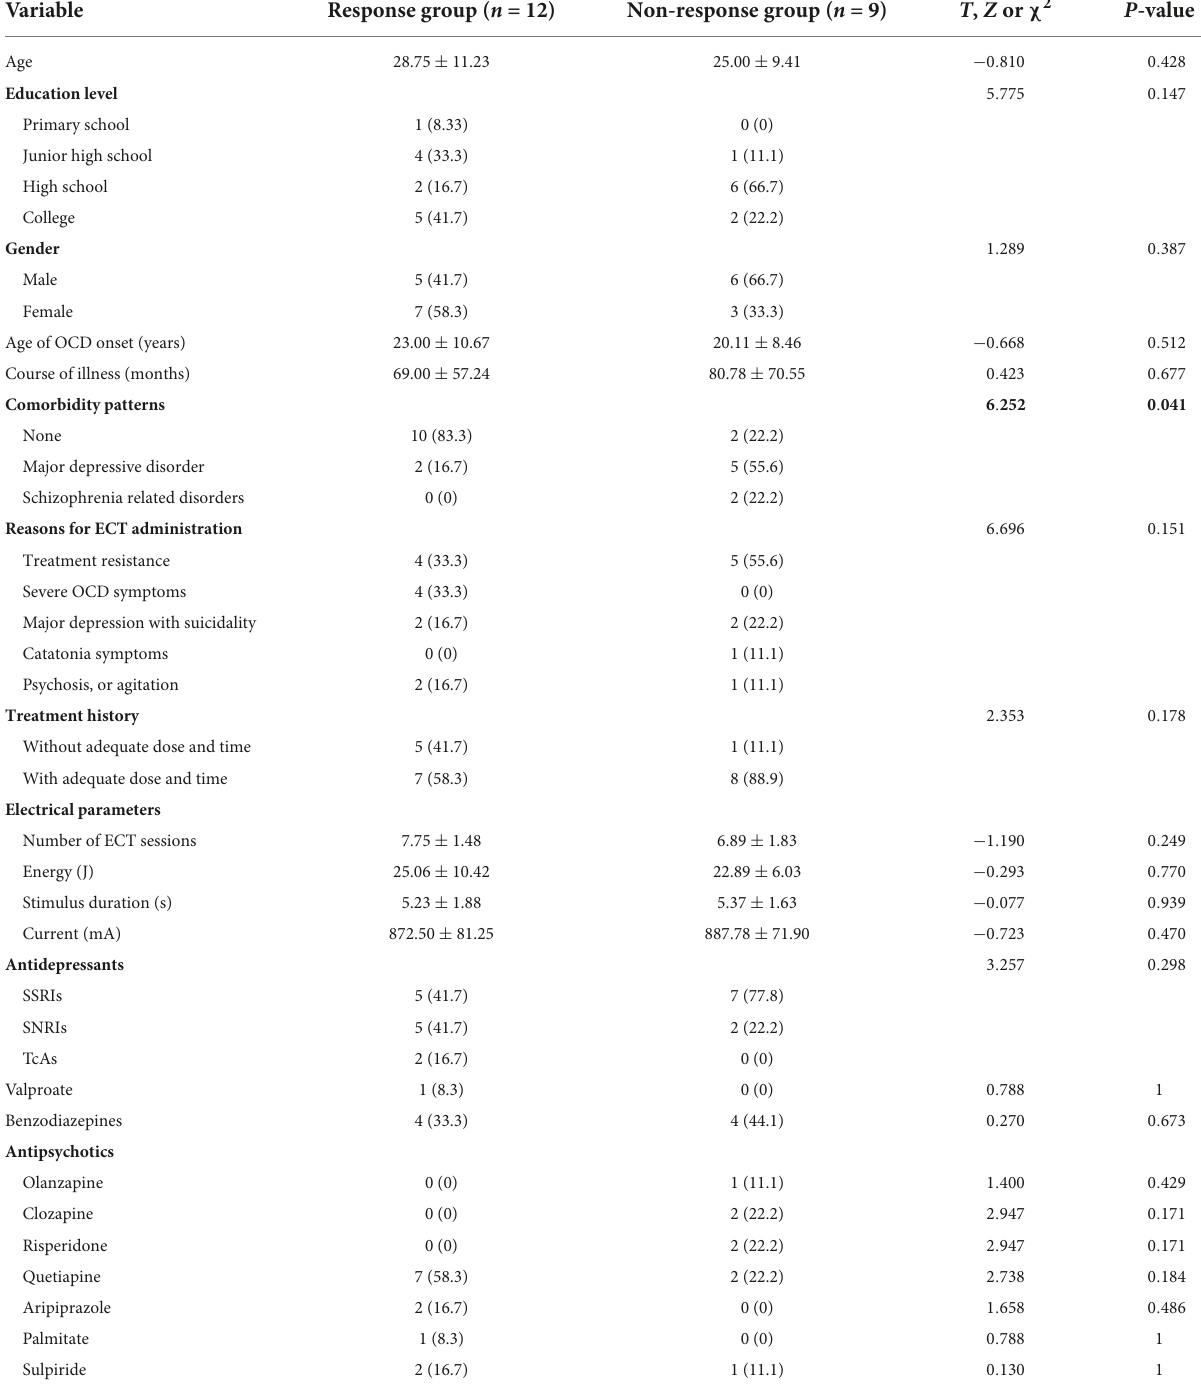
TABLE 2 Comparison of clinical characteristics between response and non-response groups.